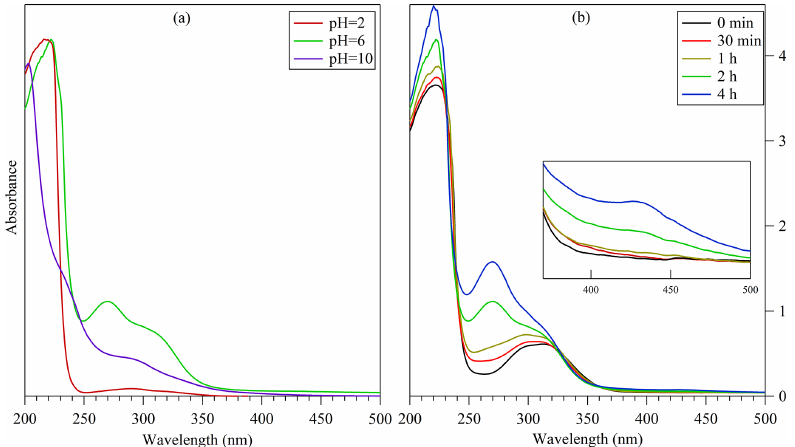
Figure 8. UV–vis absorption spectra (a) for the bulk solutions with different pH values after a bulk liquid-phase reaction of acrolein with ammonium ion for 2h and (b) for the bulk solutions with pH = 6 after different durations of the reaction of acrolein with ammonium ion. The insert in panel (b) is the zoom-in spectra for the wavelength near 430nm.